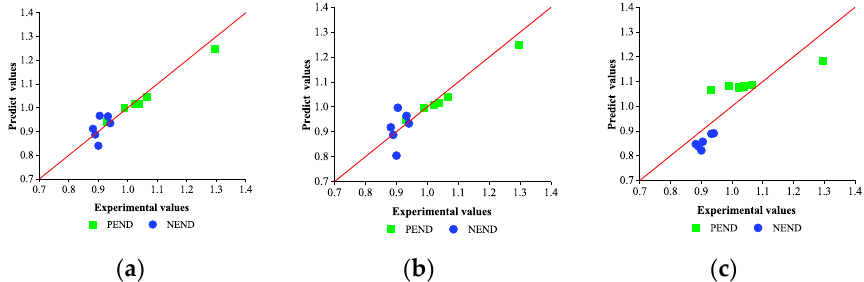
Figure 10. Comparison of the accuracy of the predicted nugget diameter of different models. ( a )